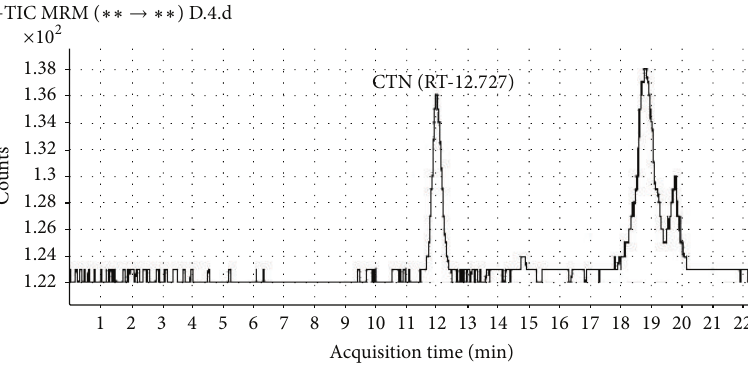
Figure 4: LC-MS/MS chromatogram of CTN for ginger sample having maximum contamination.